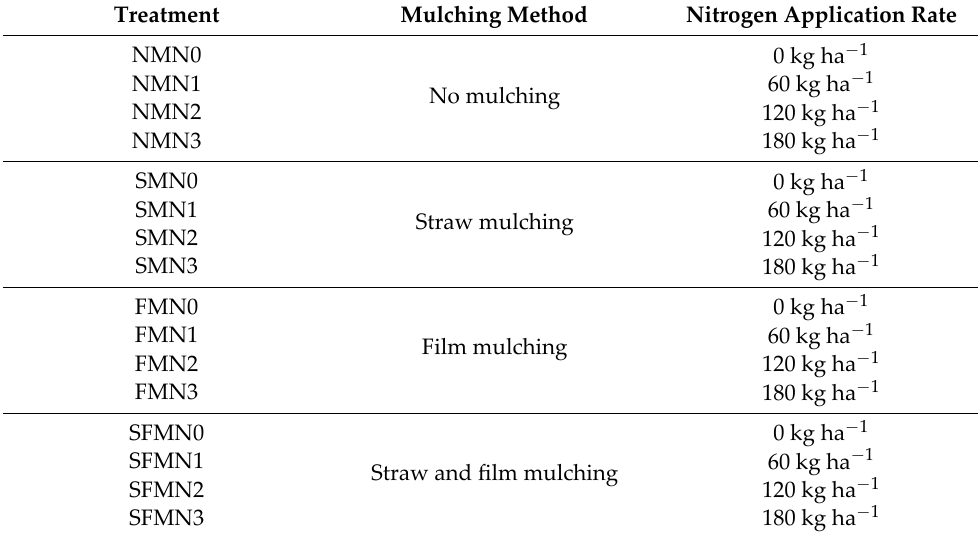
Table 2. Basic information regarding field